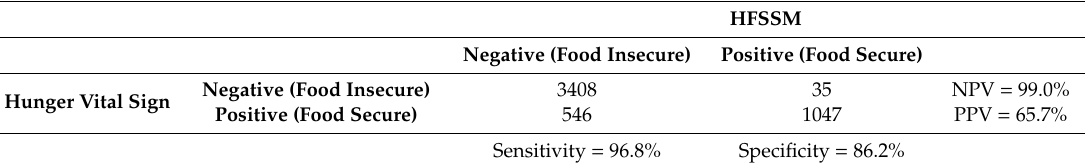
Table 3. Classification of sensitivity and specificity of the Hunger Vital Sign against the